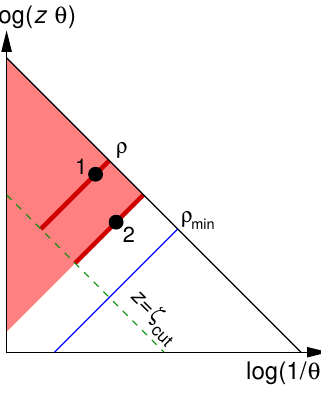
Figure 1. Lund plane corresponding to the Y m -splitter tagger for top tagging. The emission that has a larger gen- k t distance or mass is labelled 1 and that with the next largest mass is labelled 2. Emissions 1 and 2 both pass the (cid:16) cut condition shown using the dashed line. The mass (cid:26) 2 lies between (cid:26) and (cid:26) min as shown. The red shaded region represents the region over which emissions are vetoed and leads to the appearance of the primary emission contribution to the Sudakov form factor. A similar con(cid:12)guration where the second-largest mass emission, 2, is emitted as a secondary emission from emission 1, is not shown in this